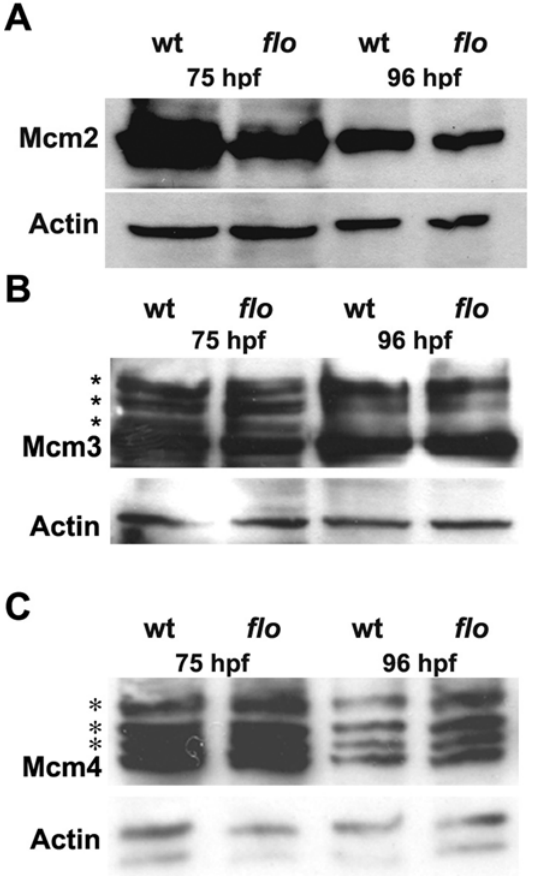
Figure 7. Reduced chromatin bound Mcm2 in the flo intestine. (A) Western analysis showing reduced levels of chromatin bound Mcm2 in 75 hpf and 96 hpf flo intestine compared with wild type siblings. By contrast, levels of chromatin bound Mcm3 (B) and Mcm4 (C) in the flo intestine are comparable to wild type. Multiple bands (*) corresponding to phospho-Mcm3 and phospho-Mcm4 are recognized by the antibodies directed against the native proteins in wt and flo samples.